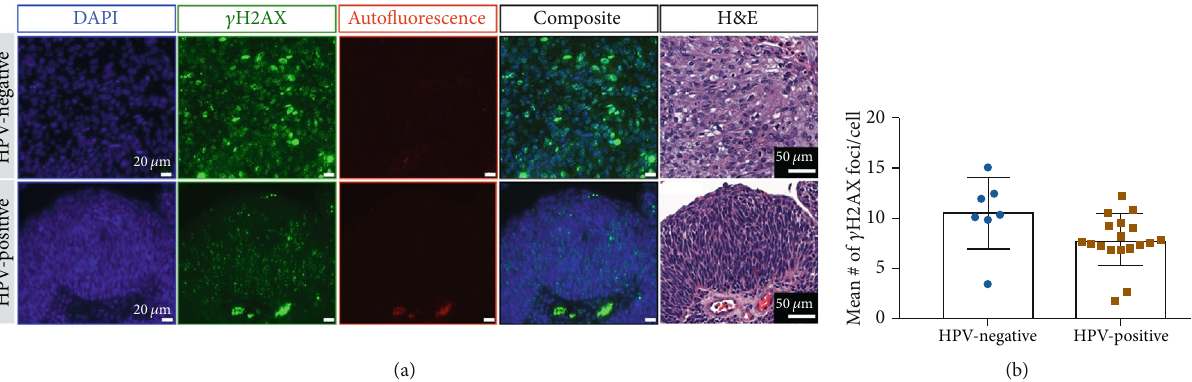
Figure 5: ɣ H2AX immuno fl uorescence in human oropharyngeal biospecimens. (a) Representative immuno fl uorescence staining images displaying nuclear stain in blue, ɣ H2AX in green, and auto fl uorescence in red. H&E corresponding with the immuno fl uorescence section is also shown. (b) Quanti fi cation of number of focus count per cell in all HPV-negative and HPV-positive oropharyngeal specimens using the entire slide. Each dot represents a